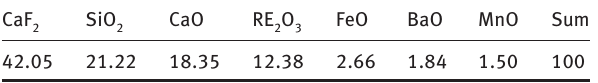
Table 2: Composition of the rare-earth-rich slag (mass fraction, %) CaF 2 SiO 2